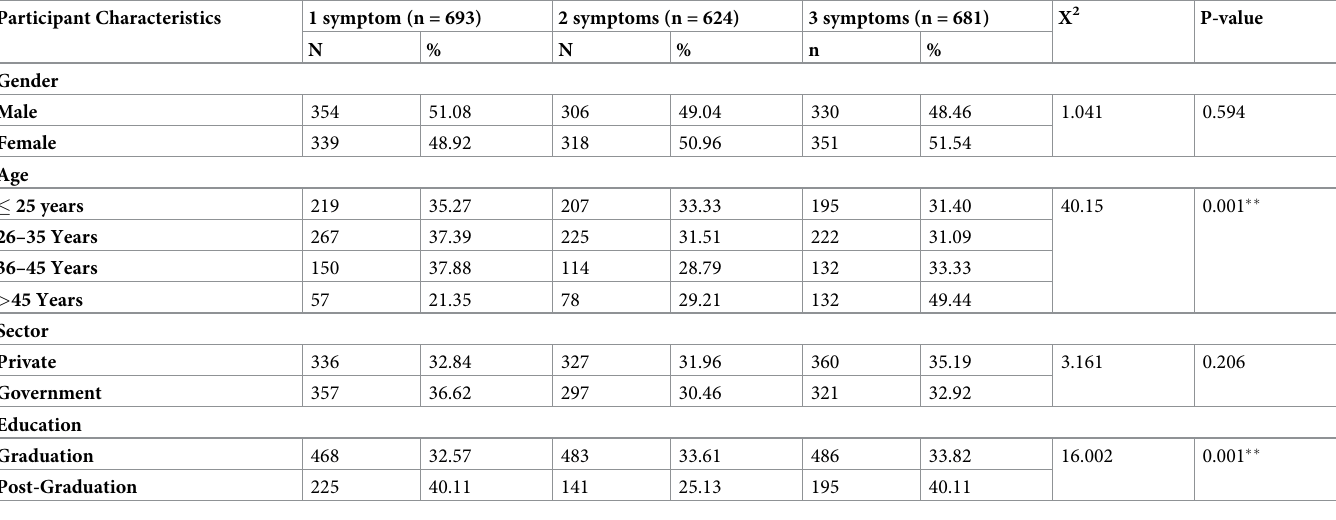
Table 5. Symptoms and prevalence of sleep apnea in studied population. Participant